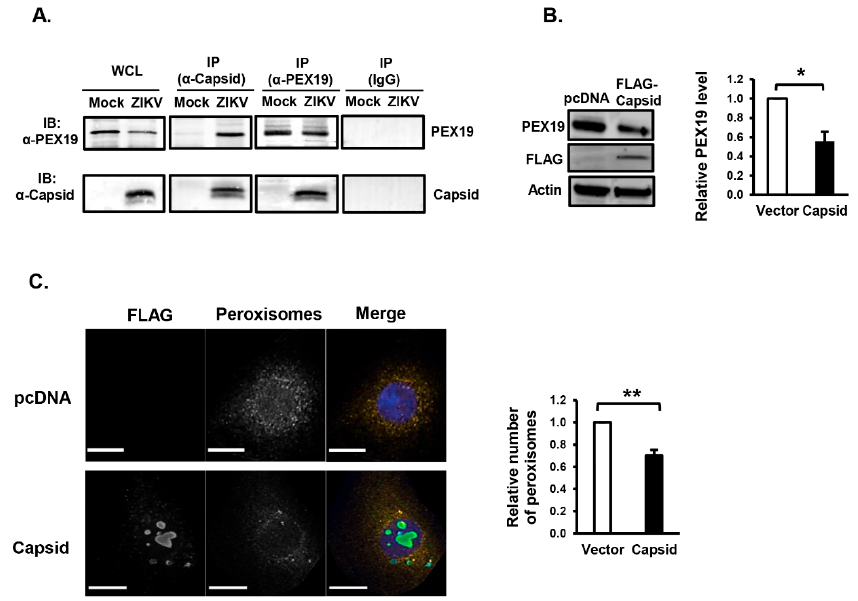
Figure 3. Expression of ZIKV capsid protein reduces peroxisome numbers. ( A ) U251 cells were infected with ZIKV PRVABC59 (MOI = 1). Forty-eight hours later, cell lysates were subjected to immunoprecipitation (IP) with rabbit anti-ZIKV capsid, rabbit anti-PEX19, or rabbit IgG followed by SDS-PAGE and immunoblotting (IB) with antibodies to PEX19 or ZIKV-capsid. WCL, whole-cell lysate. ( B ) HEK293T cells were transfected with a plasmid encoding FLAG-tagged ZIKV capsid or empty vector (pcDNA3.1) for 48 h. Cell lysates were subjected to SDS-PAGE and immunoblotting with antibodies to PEX19, ZIKV-capsid and actin. The relative levels of PEX19 (compared to actin) from